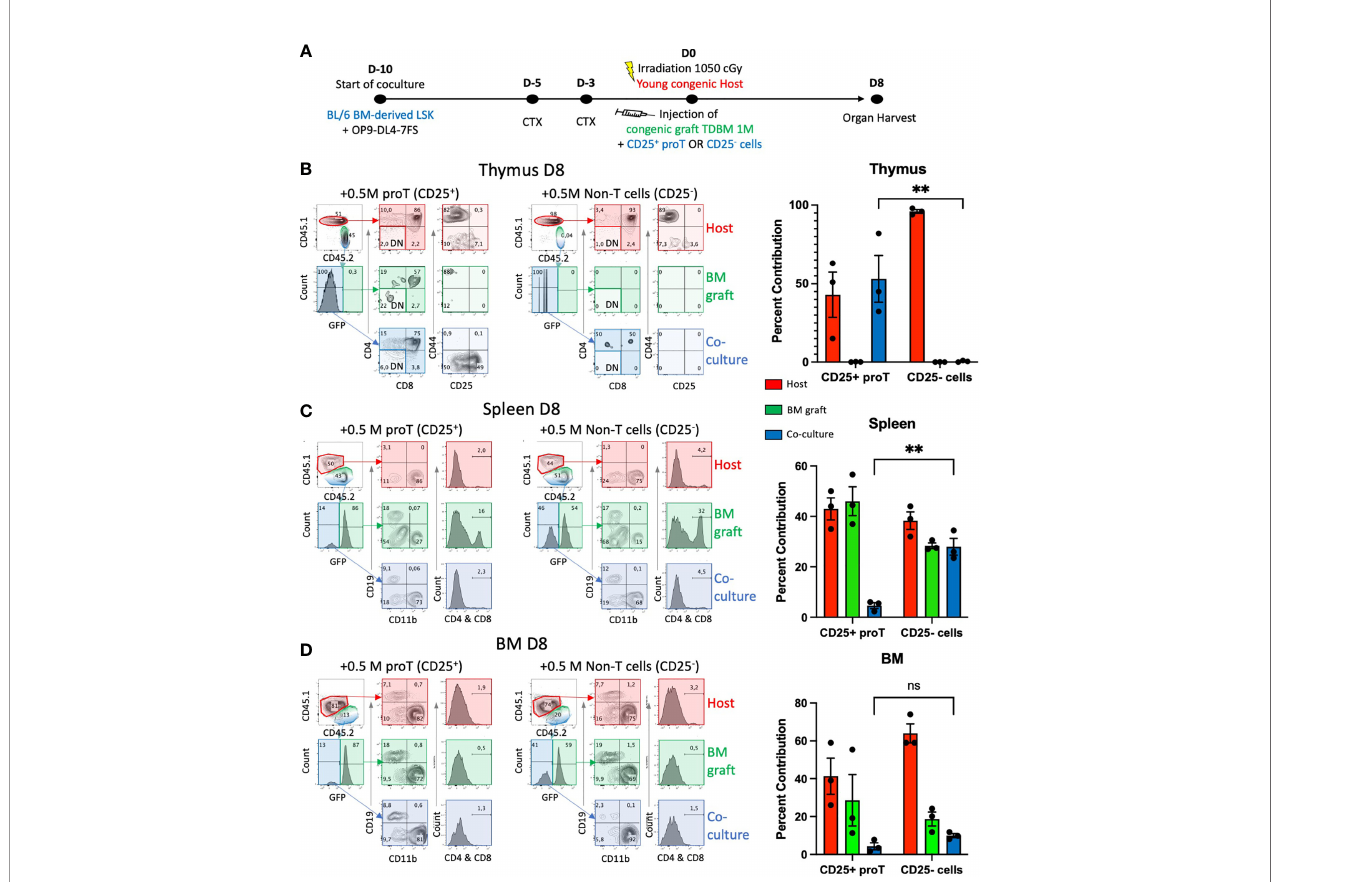
FIGURE 2 | Thymus engraftment by in vitro- generated proT cells. (A) Experimental schematic for generating proT cells in the HSC/OP9DL47FS system. BM-derived LSK cells from CD45.2 mice were obtained and co-cultured with OP9-DL4-7FS cells 10 days prior to injection. Young (8-12 wks) B6 CD45.1 mice were intraperitoneally injected with cyclophosphamide (CTX) 5 days and 3 days prior to injection and lethally irradiated at 1.05 Gy on the day of injection. All mice were intravenously injected with 1 x10 6 hematopoietic cells extracted from the BM of CD45.2 GFP + mice that were T cell-depleted (TDBM cells) and 5 x10 5 CD25 + or CD25 - culture-derived cells. On D8 post injection, graft and host contribution to the host (B) thymus, (C) spleen, (D) BM, were analyzed by fl ow cytometry. In (B) , CD44 vs. CD25 panels were gated on CD4- CD8- DN cells (lighter shade for DN-gated panels). For each organ, the contribution of host (red), GFP + BM graft (green) or coculture derived CD25 + or CD25 - cells (blue) were calculated and graphed. Signi fi cant difference between coculture-derived cells was noted (** p <0.01 analyzed by two-way ANOVA, error bars depict SEM), ns, not signi fi